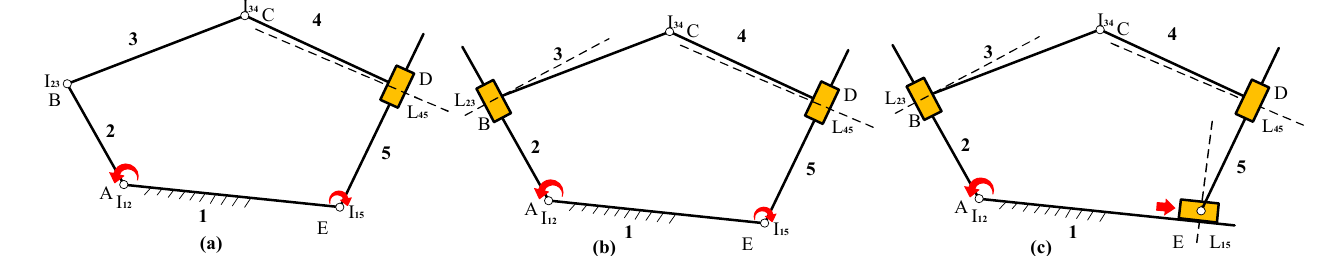
Figure 11. Single-loop five-bar planar linkage with ( a ) one prismatic joint, ( b ) two pris- matic joints, ( c ) three prismatic joints. Table 4. Instant centers of five-bar planar linkage with one prismatic joint.